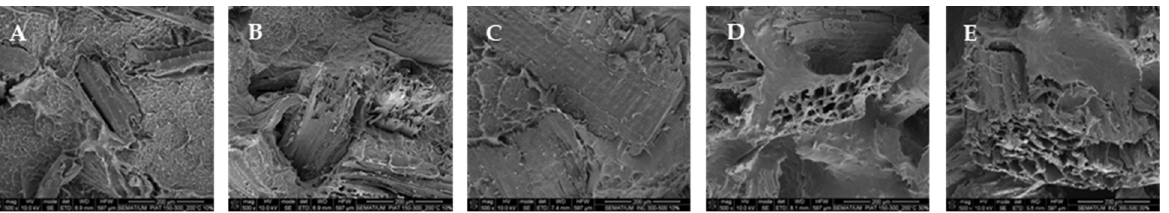
Figure 11. Morphological details of MDPE/wood composites. From left to the right : ( A ) fiber mechanically anchored to the matrix (MDPE/10% 150–300 µ m); ( A , B ) lack of interfacial adhesion of wood to polymer (MDPE/10% 150–300 µ m); ( C ) fiber on its transversal direction embodied on the polymer (MDPE/10% 300–500 µ m); ( D ) wood bundle well embodied on the polymer surrounded by large voids (MDPE/30% 150–300 µ m); ( E ) wood bundle poorly wet by the polymer (MDPE/30% 300–500 µ